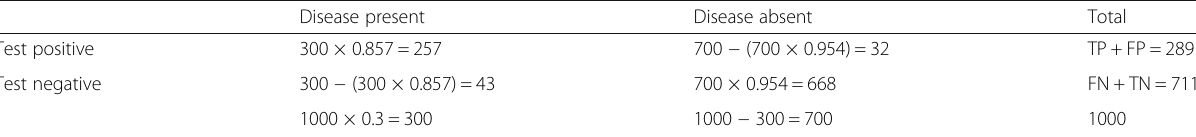
Table 2 Natural frequency estimates based on the summary sensitivity and specificity and median prevalence of strep A infection from the systematic review of rapid tests for diagnosing group A streptococcus in children with sore throats